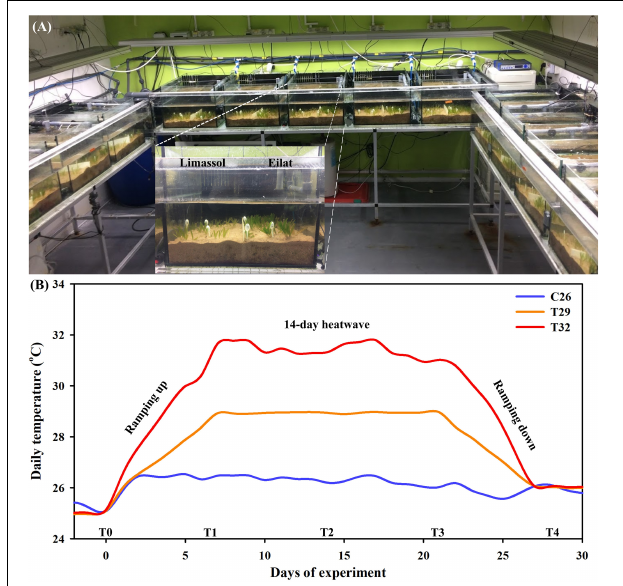
FIGURE 2 | The seagrass dedicated mesocosm facility, containing 15 aquaria fully controlled for water temperature, light, and salinity (A) . Aquaria were layered with natural sediment and filled with artificial seawater. Each aquarium contained 10 invasive and 10 native H. stipulacea plants, separated by plastic dividers ( A , inset). Average water temperature profiles ( n = 2 sensors in two tanks from each treatment) during the microcosm experiment (day 0–28) (B) . Shown are the three thermal treatments (26 ◦ C [control], 29 ◦ C and 32 ◦ C), the time points (T0–T4) on which measurements and samples were taken, and the different stages of the experiment – 6-days of ramping up the temperature, the 14-day heat wave, followed by 6-days of ramping temperatures down again to control levels (26 ◦